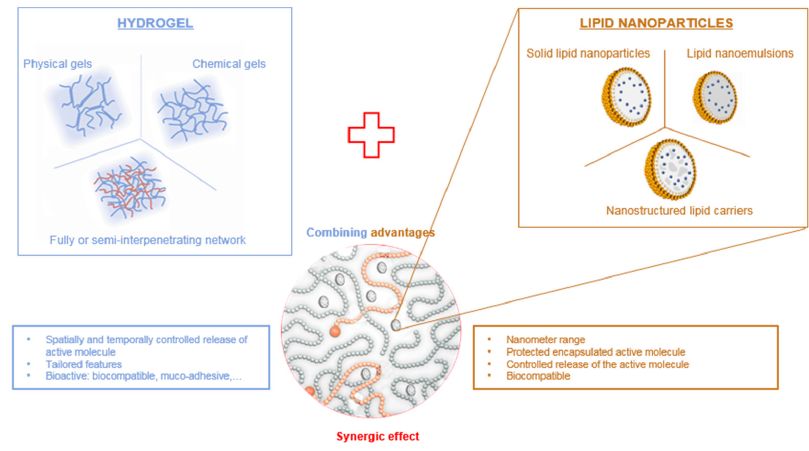
Figure 1. Combination of hydrogels and lipid